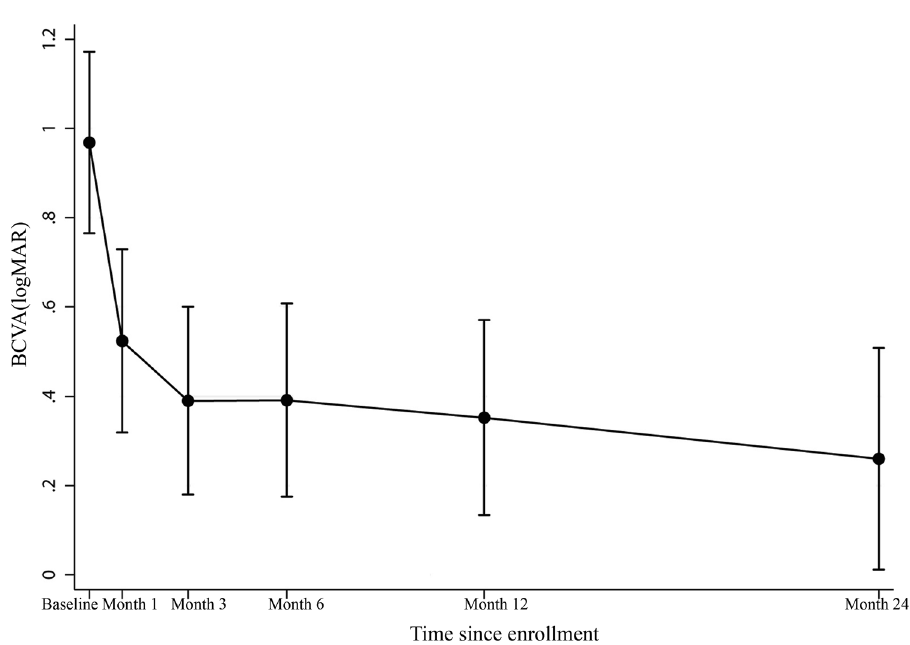
Figure 2. Estimates of mean best corrected visual acuity (BCVA) over two years after presentation produced by a linear mixed model. Vertical lines indicate the 95% confidence